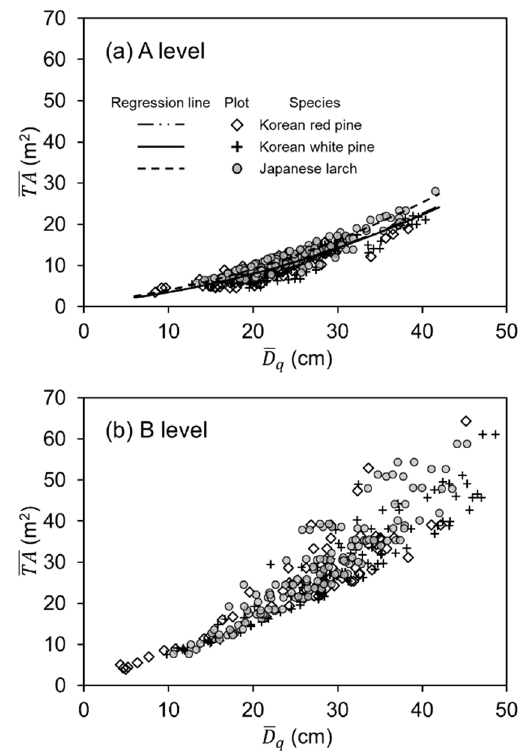
Figure 3. Scatterplots of mean individual tree area ( TA ) over quadratic mean diameter ( D q ) used for modeling ( a ) A-level stocking and ( b ) B-level stocking by species. Regression lines of TA – D q via Equation (4) for A-level stocking displayed using fixed effects of Equation (8) developed in Table 2.